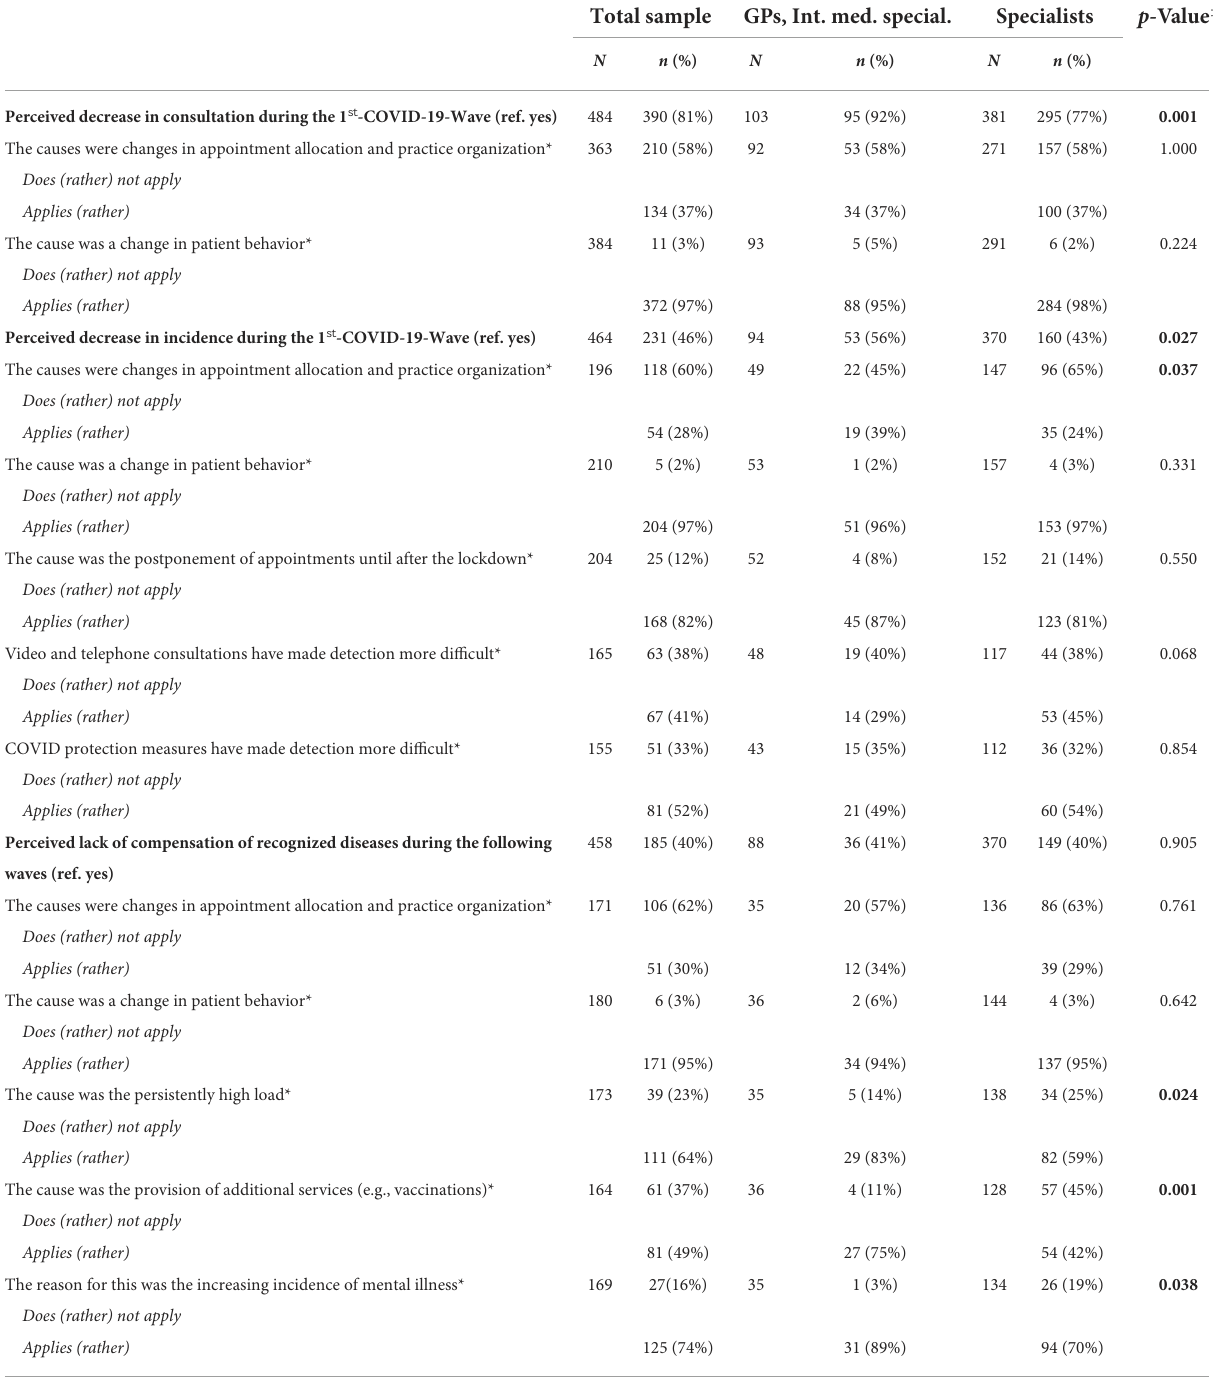
TABLE 4 Perception and Causes from the outpatient physicians’